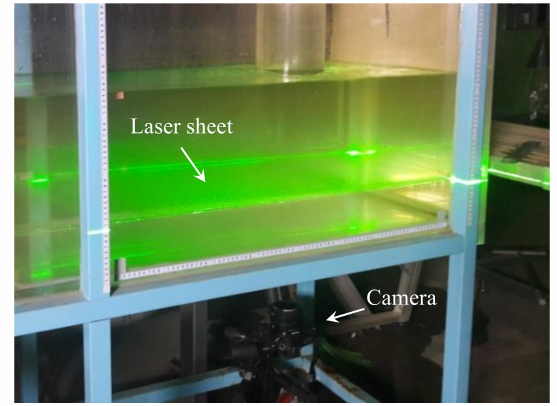
Figure 5. Photos of the experimental set-up for particle image velocimetry (PIV) measurements.